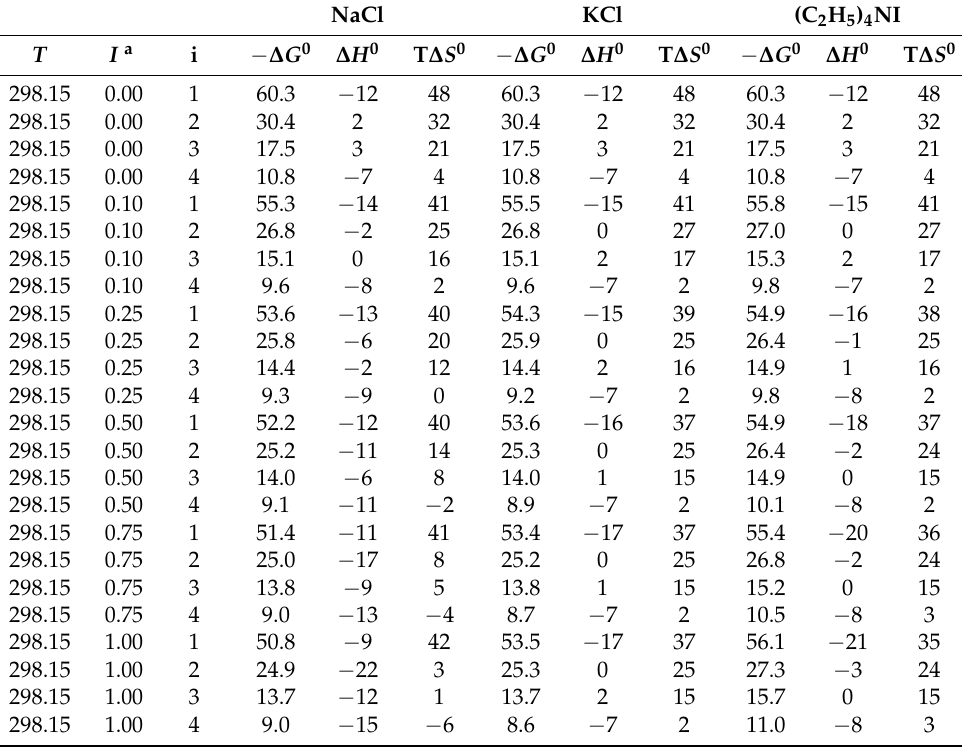
Table 4. Thermodynamic parameters ( ∆ G 0 , ∆ H 0 and T ∆ S 0 , in kJ mol − 1 ) for the four GLDA protona- tion steps (i) at different ionic strength values and T = 298.15 K and p = 0.1 MPa. NaCl